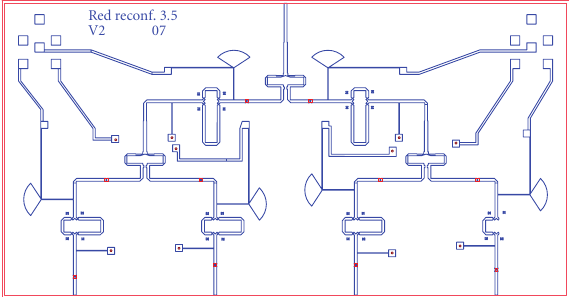
Figure 8: Drawing of the switchable feeding